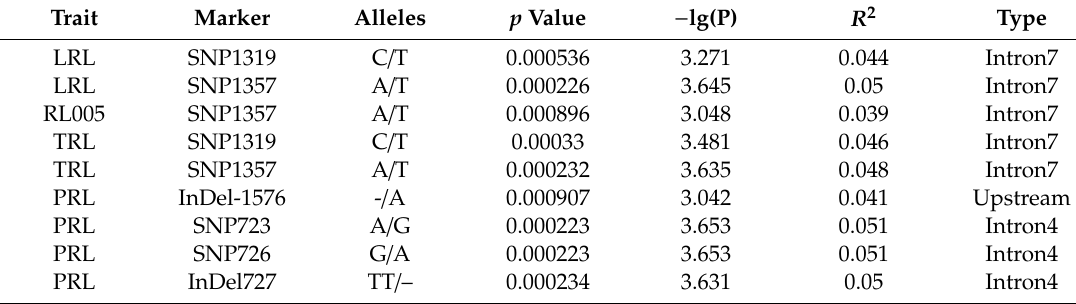
Table 2. Significant markers associated with root